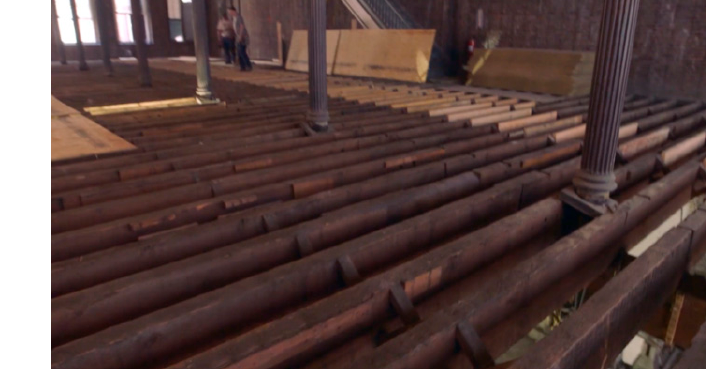
Figure 3. Historic joist floor.